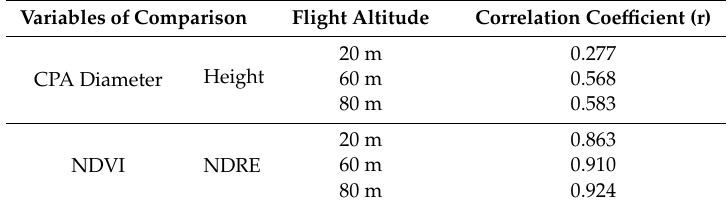
Figure 14. RMSD value of NDVI (blue) and NDRE (green) for each compared flight altitude. Table 6. Correlation analysis between crown diameter and height, and NDVI and NDRE at di ff erent flight